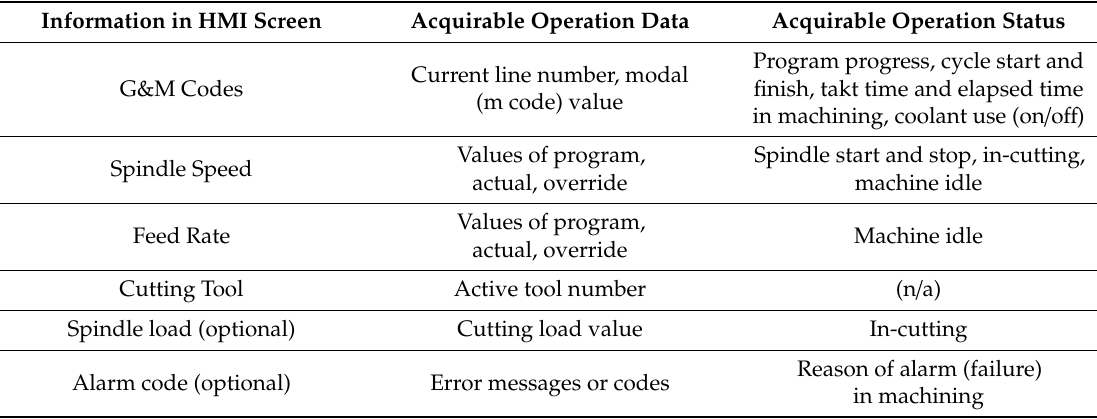
Table 3. Operational data and status which can be collected from the HMI screen.